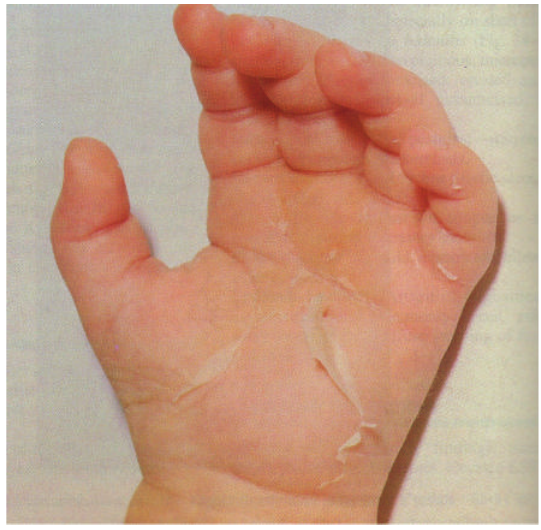
Figure 15: Kawasaki’s disease [9, page 425].